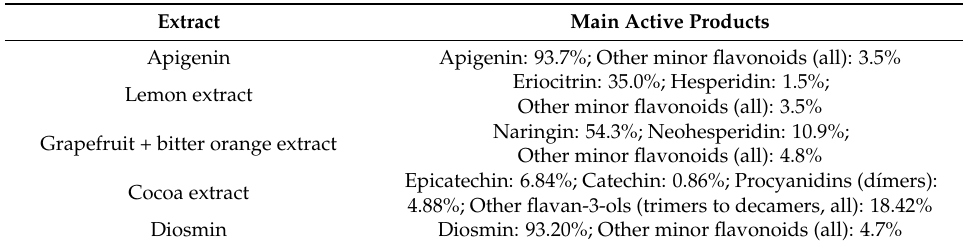
Table 1. Main flavonoids of the products used in the present